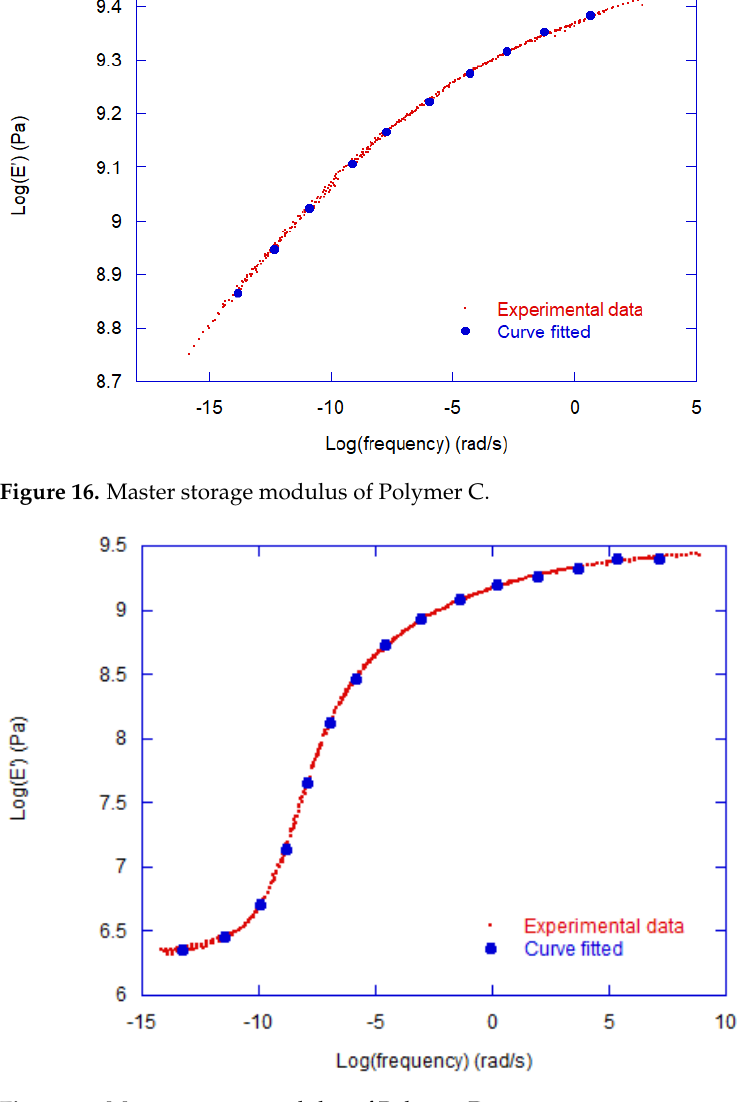
Figure 17. Master storage modulus of Polymer D. Table 3. WLF factors at reference temperature 50 ◦